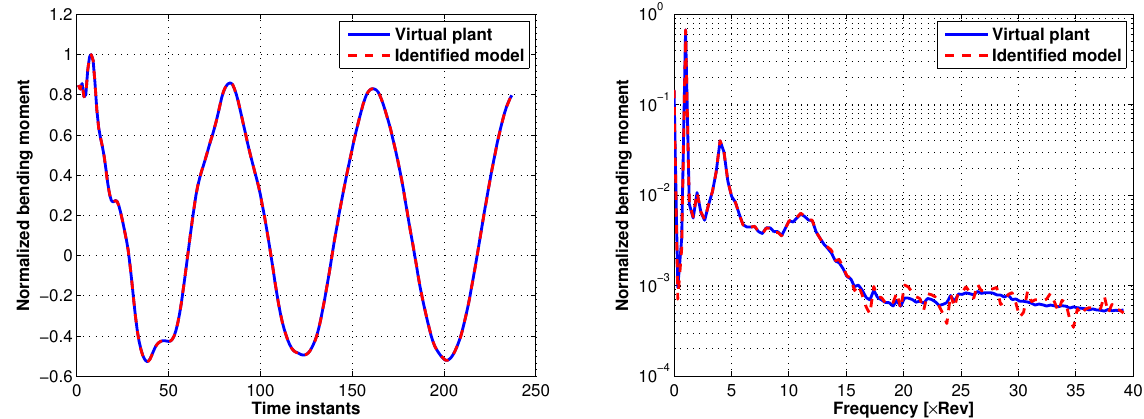
Figure 4. Comparison between measured (solid line) and predicted (dashed line) normalized blade root edgewise bending moment, in the time (left) and frequency (right) domains.